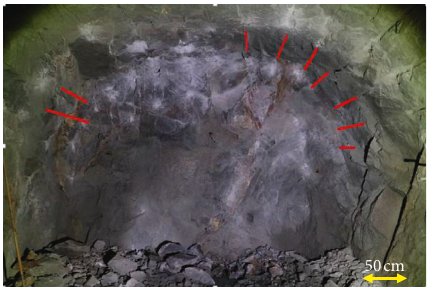
Figure 11: Blasting effect of double-wedge